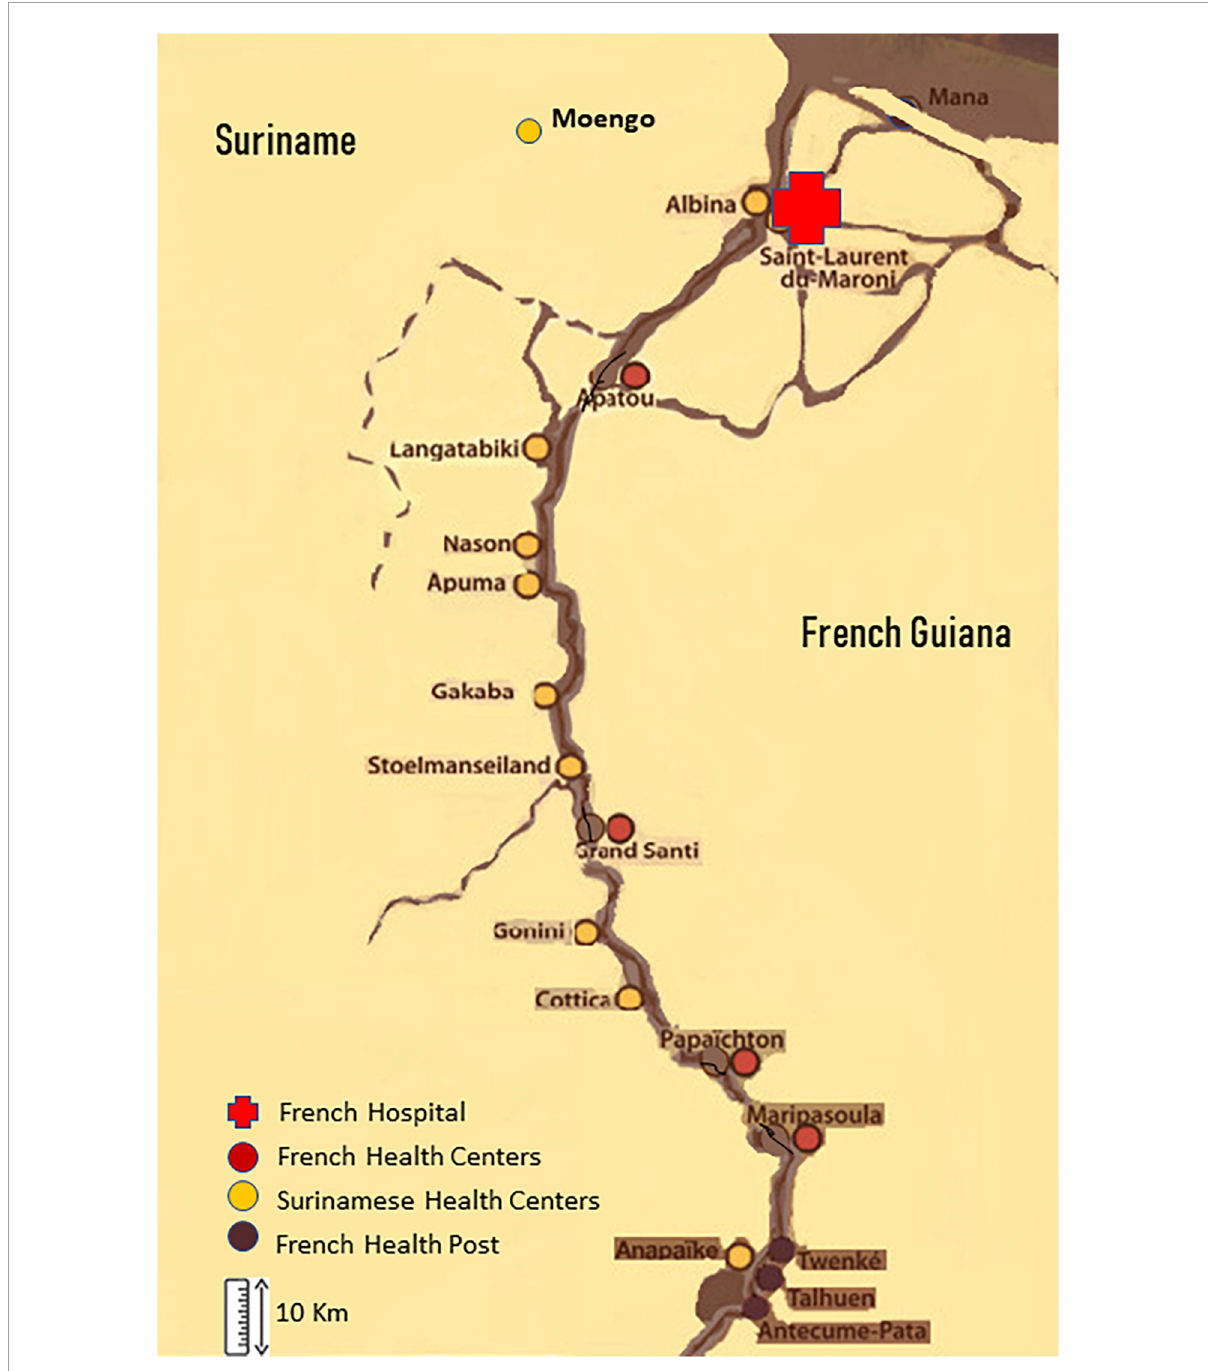
FIGURE1 Health structures along the border between Suriname and French Guiana.